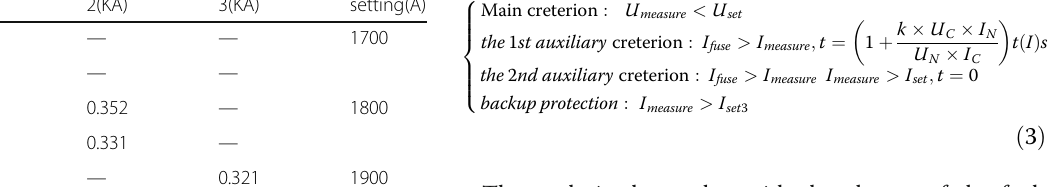
Table 3 RMS current of the collector network when single- phase faults occurres at K1 ~ K6